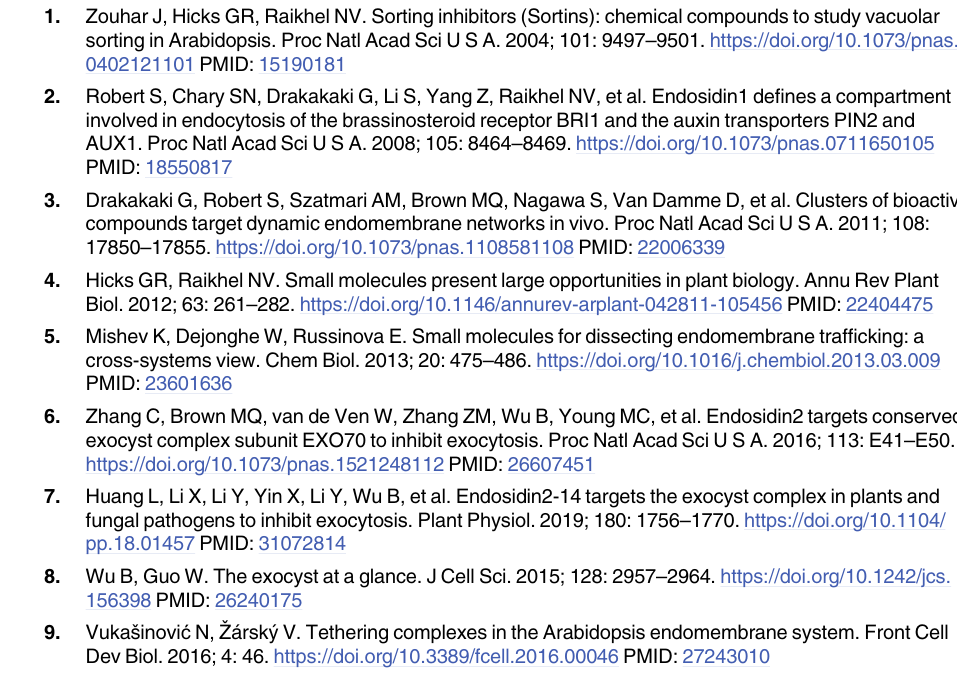
S1 Table. Primers used to prepare DNA